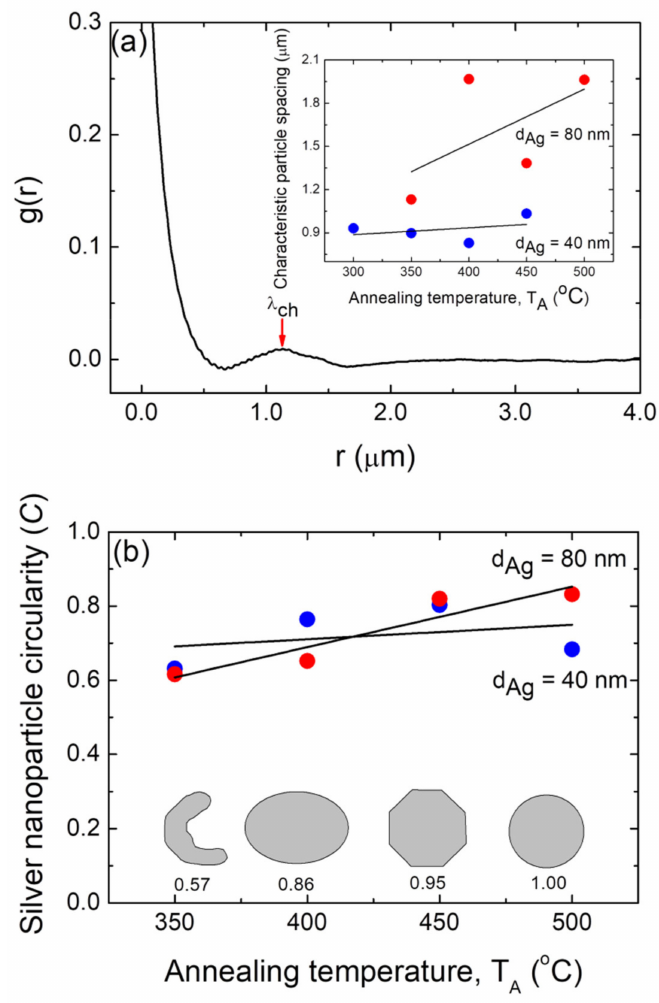
Figure 6. ( a ) Typical measured radially averaged autocorrelation function, g(r), for the silver nanopar- ticle positions for a typical sample with d Ag = 80 nm and T A = 350 ◦ C. Arrow indicates the corre- sponding characteristic particle spacing λ ch (at maximum). Inset: positional correlation as a function of the annealing temperature, T A , for samples with two different thicknesses: d Ag = 40 nm (blue circles) and 80 nm (red circles). ( b ) Mean circularity of the silver nanoparticles formed as a function of the annealing temperature, TA, for samples with two different thicknesses: d Ag = 40 nm (blue circles) and 80 nm (red circles). Inset: elongated, oval, polyhedral, and circular shapes and their corresponding circularities. In all of these figures, the black lines are guides for the